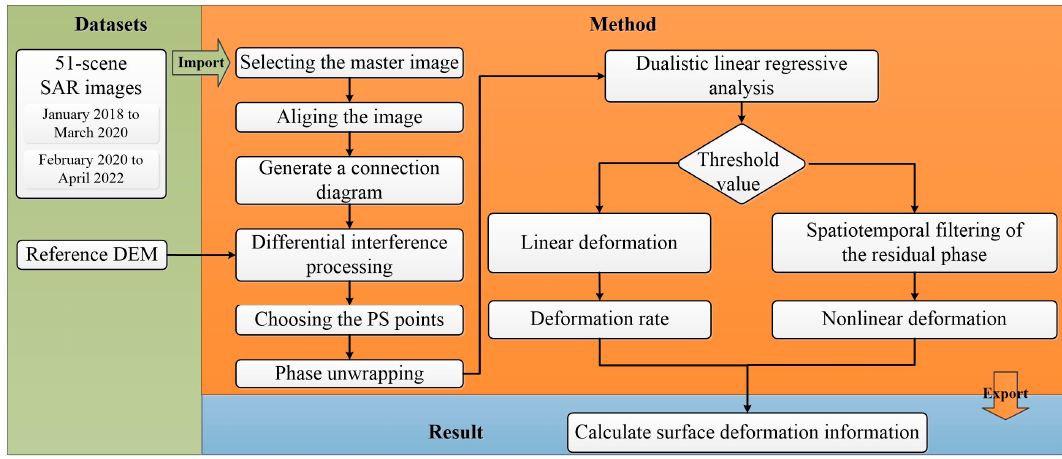
Figure 2. PS-InSAR flowchart.